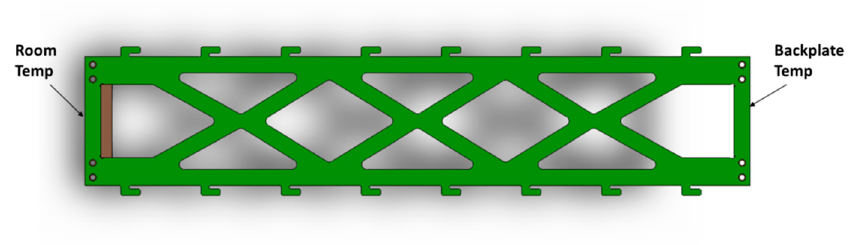
Figure 7. 3D model used to simulate the applied thermal loads. On the baseplate, the thermal loads applied for this simulation are − 150 °C and 150 °C.